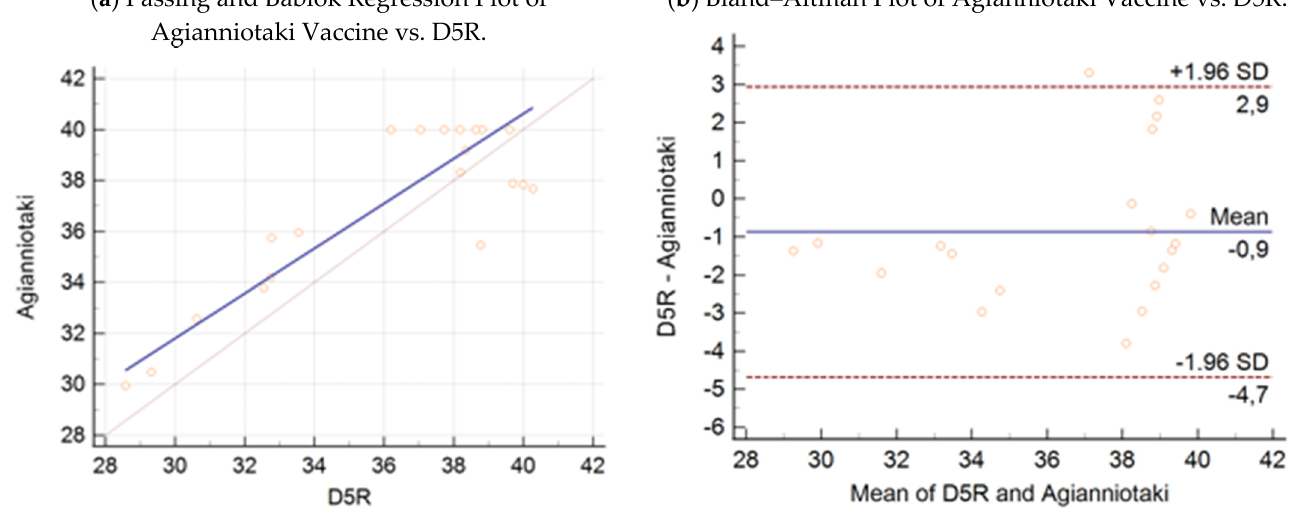
( a ) Passing and Bablok Regression Plot of